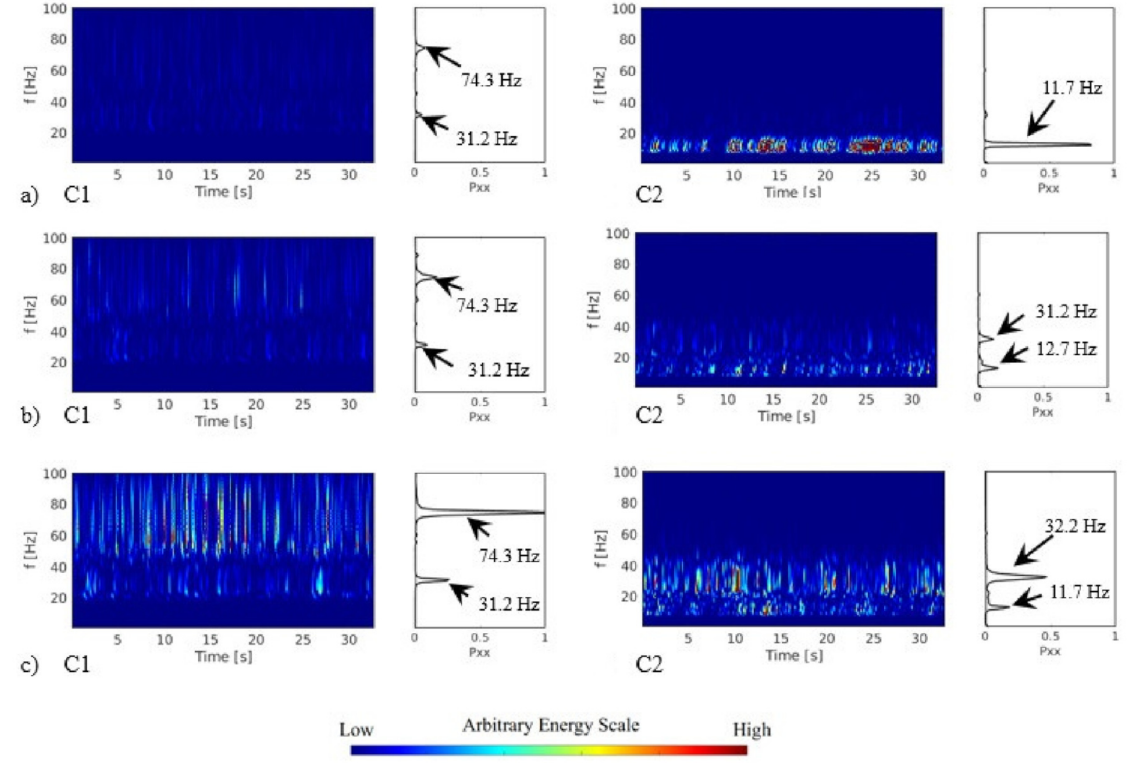
Figure 12. Continuous wavelet and Fourier spectra of acceleration signals of the case with two cylinders free to vibrate: ( a ) C1—first cylinder free to vibrate, Vr = 11; C2—second cylinder free to vibrate, Vr = 30; ( b ) C1—first cylinder free to vibrate, Vr = 15; C2—second cylinder free to vibrate, Vr = 41; ( c ) C1—first cylinder free to vibrate, Vr = 18; and C2—second cylinder free to vibrate, Vr =